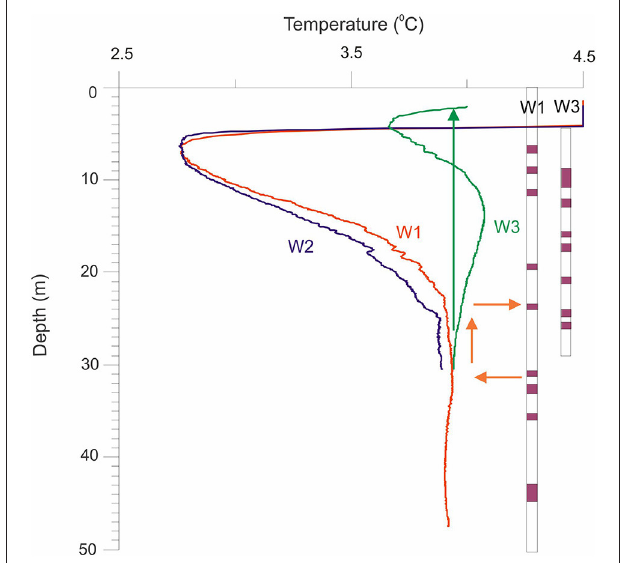
FIGURE 6 | Temperature logs for W1, W2 and W3. Arrows indicate fluid flow (entry, upward flow, and exit). At the time of logging, W3 was flowing artesian, as represented by the vertical green arrow extending to surface. The purple horizontal bars represent the fractures/fracture zones interpreted from the resistivity and full waveform logs for each well as shown in Figure 5 .